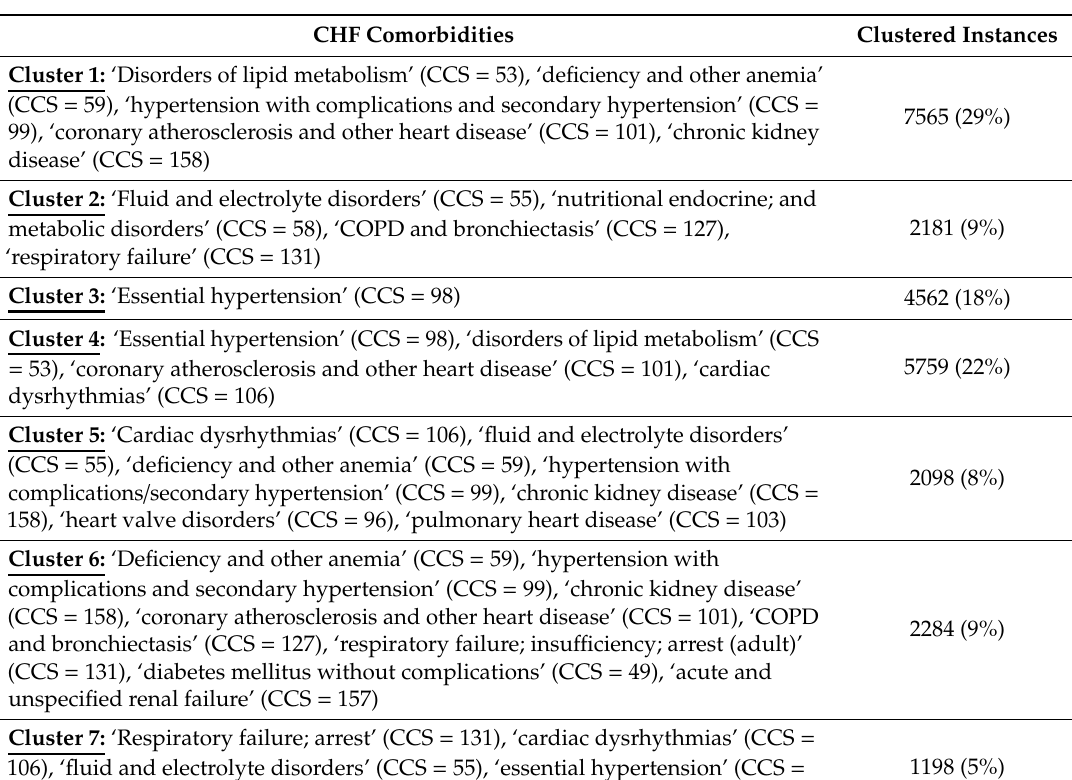
Table 5. Clustering of CHF Comorbidities Using the k-means Partitional Algorithm. CHF Comorbidities Clustered